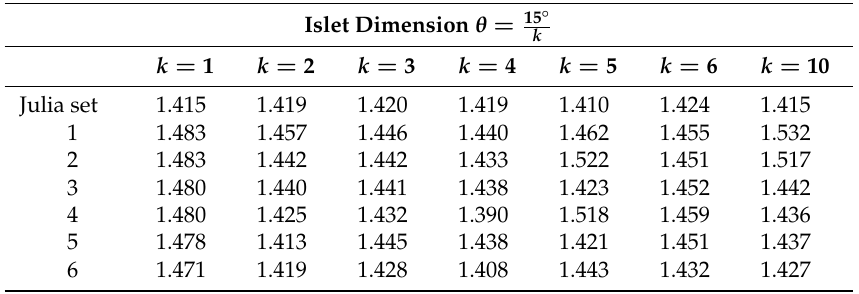
Table 4. The dimension of each of the islets when θ = 15 ◦ dimension was used to find the dimension of these